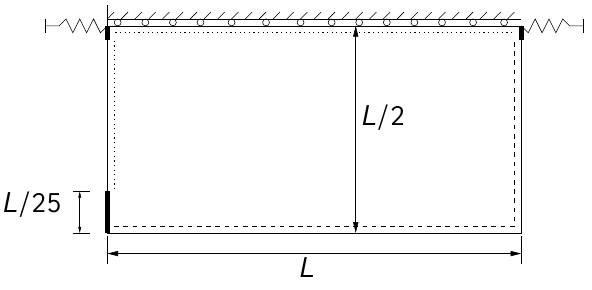
Figure 2. Boundary conditions for filtering. The bold lines corre- spond to Dirichlet BC ˜ ρ = 1 . 0, the dotted lines correspond to Neu- mann BC ∂ ˜ ρ/∂ n = 0, and the dashed lines correspond to Dirichlet BC ˜ ρ = 0 . 0. The length of the bold lines around the two springs is L / 50.